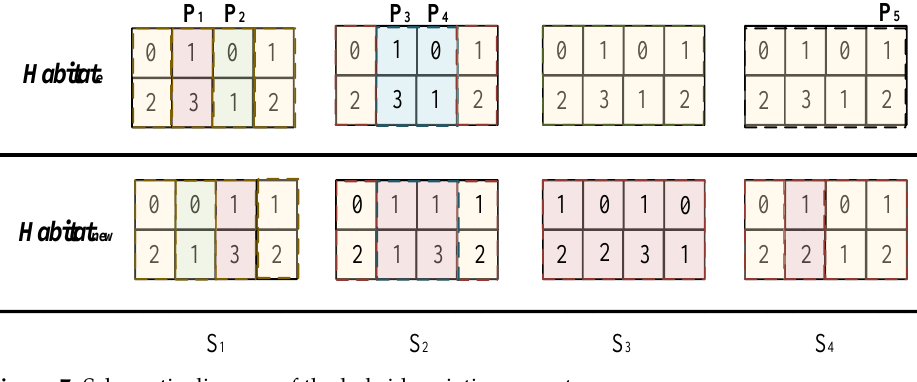
Figure 7. Schematic diagram of the hybrid variation